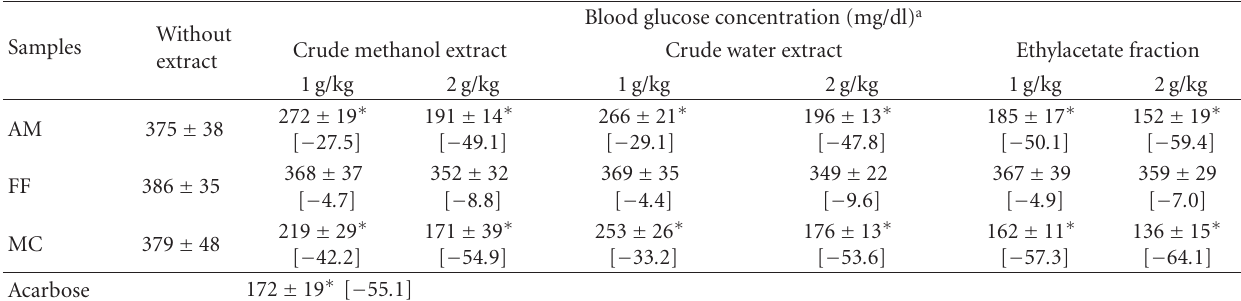
Table 3: Blood glucose level in glycogen-loaded mouse after oral administration of AM, FF, and MC extracts. Samples